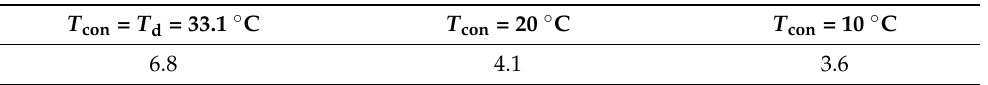
Table 2. SEC for water production in the AWHA process employing MIL-160 in the Riyadh-Old region at T re = 80 ◦ C (dry